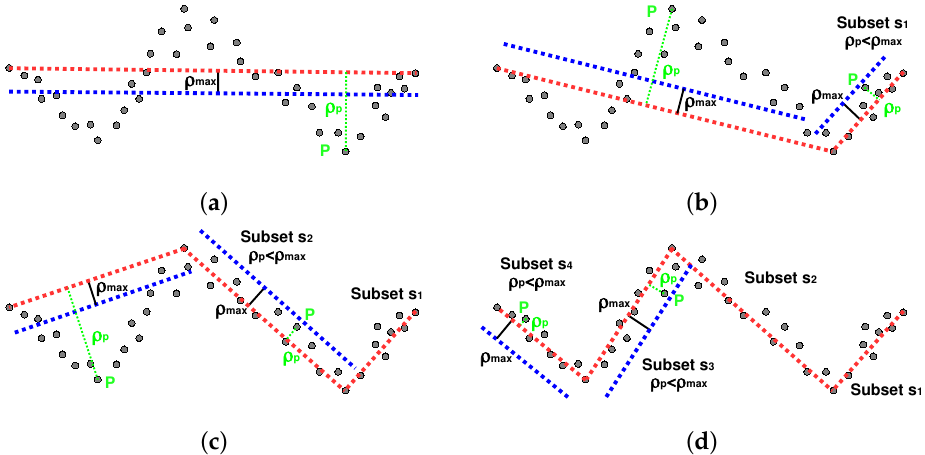
Figure 7. Iterative End Point Fit (IEPF) algorithm: ( a ) initial splitting process considering k points, ( b , c ) recursive split, and ( d ) stopping